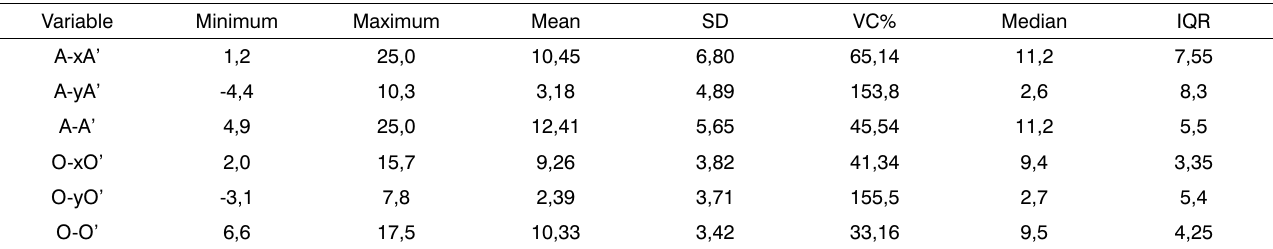
Table 1. Descriptive statistics for the study variables, found from measurements of point A and the orbit point, in preoperative and early posto- perative